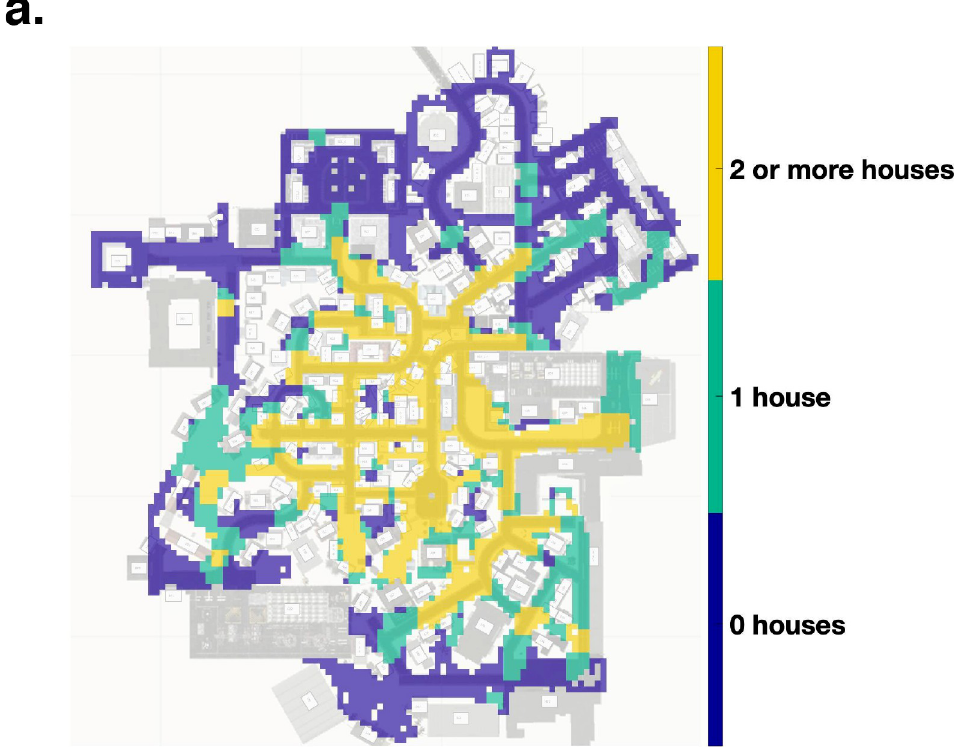
Fig 9. Triangulation. Location data of all participants plotted on the map of Seahaven. The color code indicates how many of the gaze-graph-defined landmark houses were viewed by participants at each location.